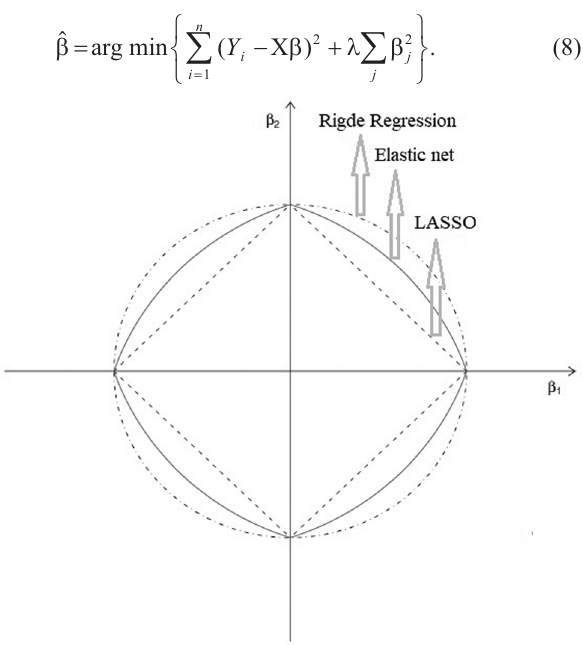
Figure 1 - Geometry of the penalties. Source: Zou and Hastie (2005).